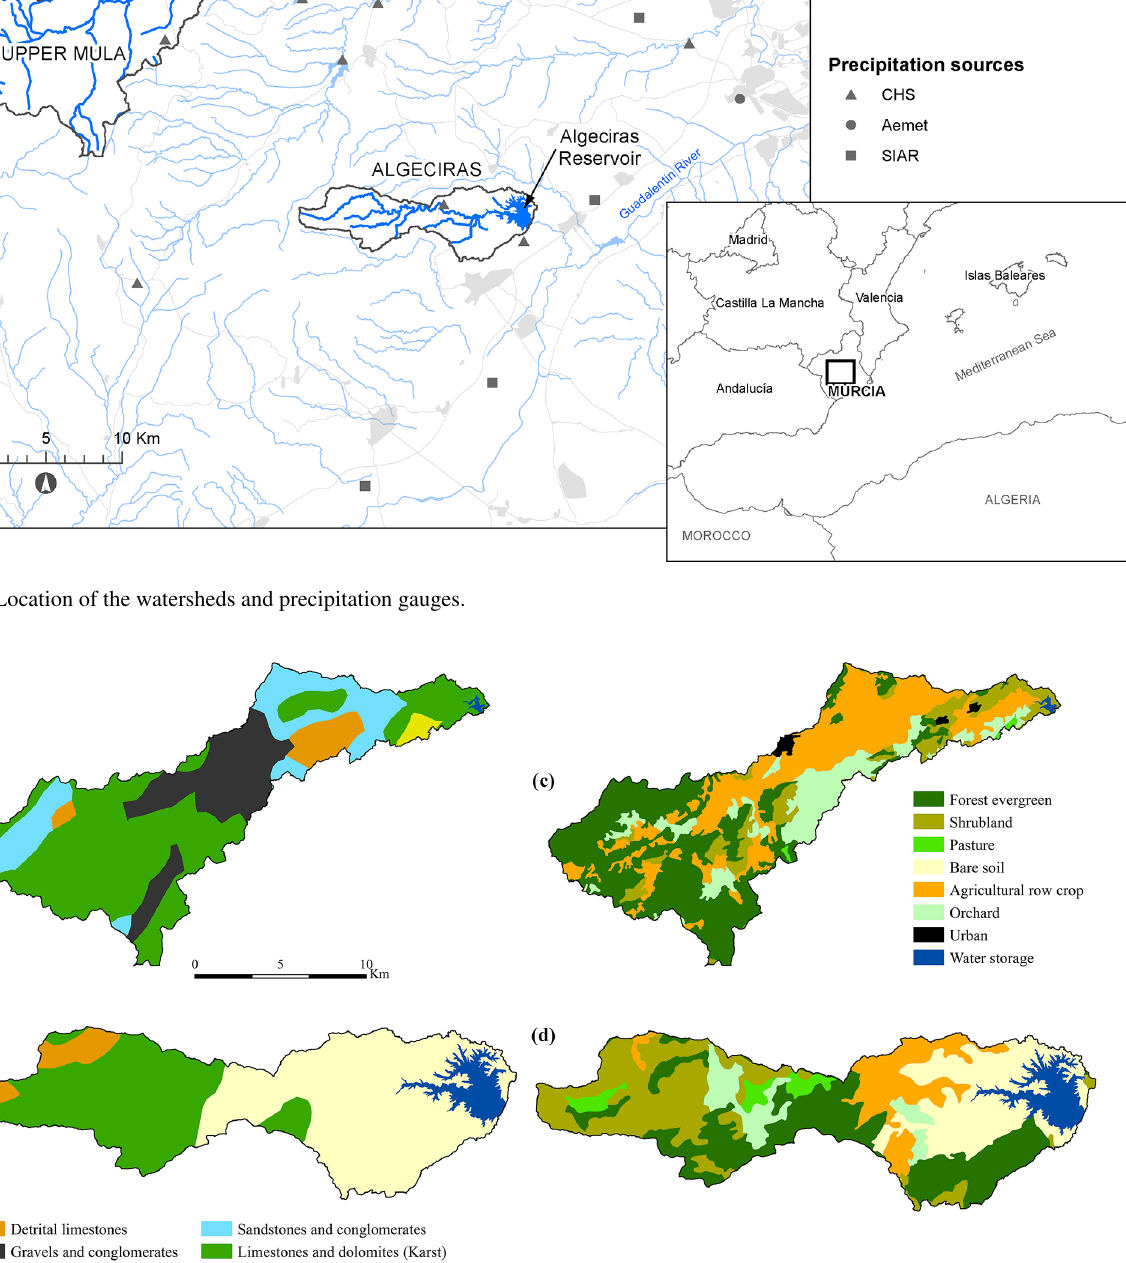
https://doi.org/10.5194/hess-26-1243-2022 Hydrol. Earth Syst. Sci., 26, 1243–1260,